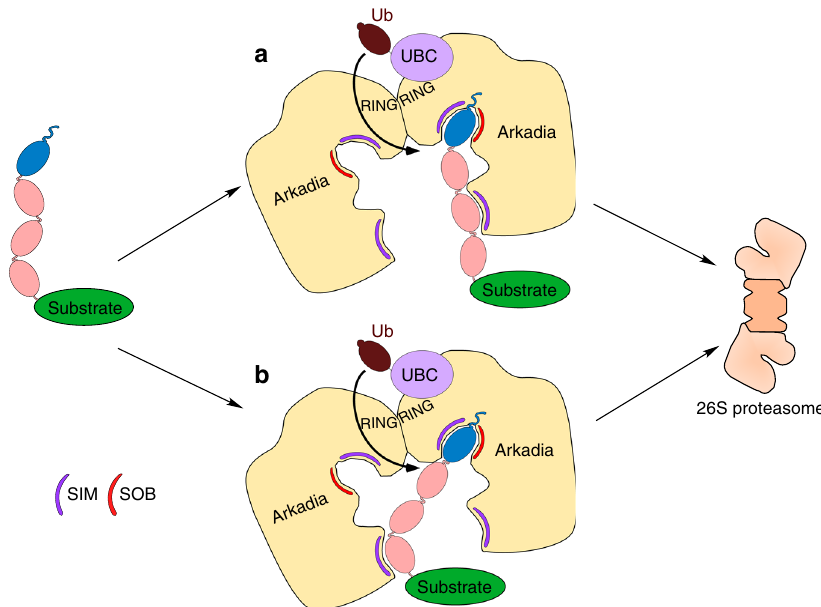
Fig. 6 Model of substrate selection by Arkadia. Shown are two modes by which an Arkadia dimer might bind to substrates tagged with SUMO1-capped SUMO2/3 chains and, together with a ubiquitin-conjugating enzyme (UBC), mediate its ubiquitylation and targeting to the proteasome. In a , the distal SUMO1 moiety is bound by SIM1 as well as the SOB motif of one of the Arkadia subunits, and a SUMO2/3 moiety in the chain is bound by SIM2 of the same subunit. In b , SUMO1 is bound by one Arkadia subunit, whereas a SUMO2/3 moiety in the chain is bound by SIM2 of the other Arkadia subunit. It is also possible that the SIM2 elements of both subunits contribute to binding (not shown). See main text for further